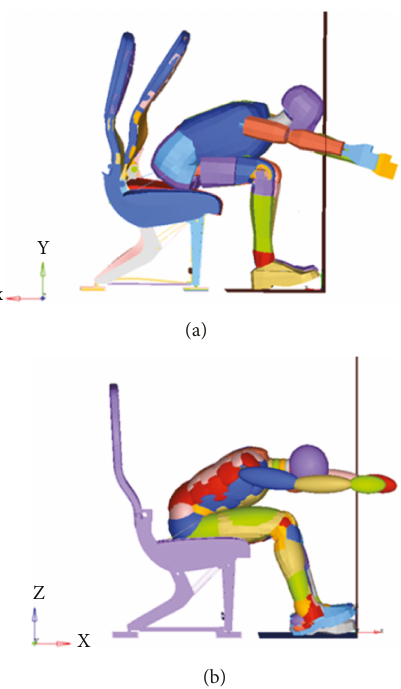
Figure 3: Full FE (a) and full MB (b) models.